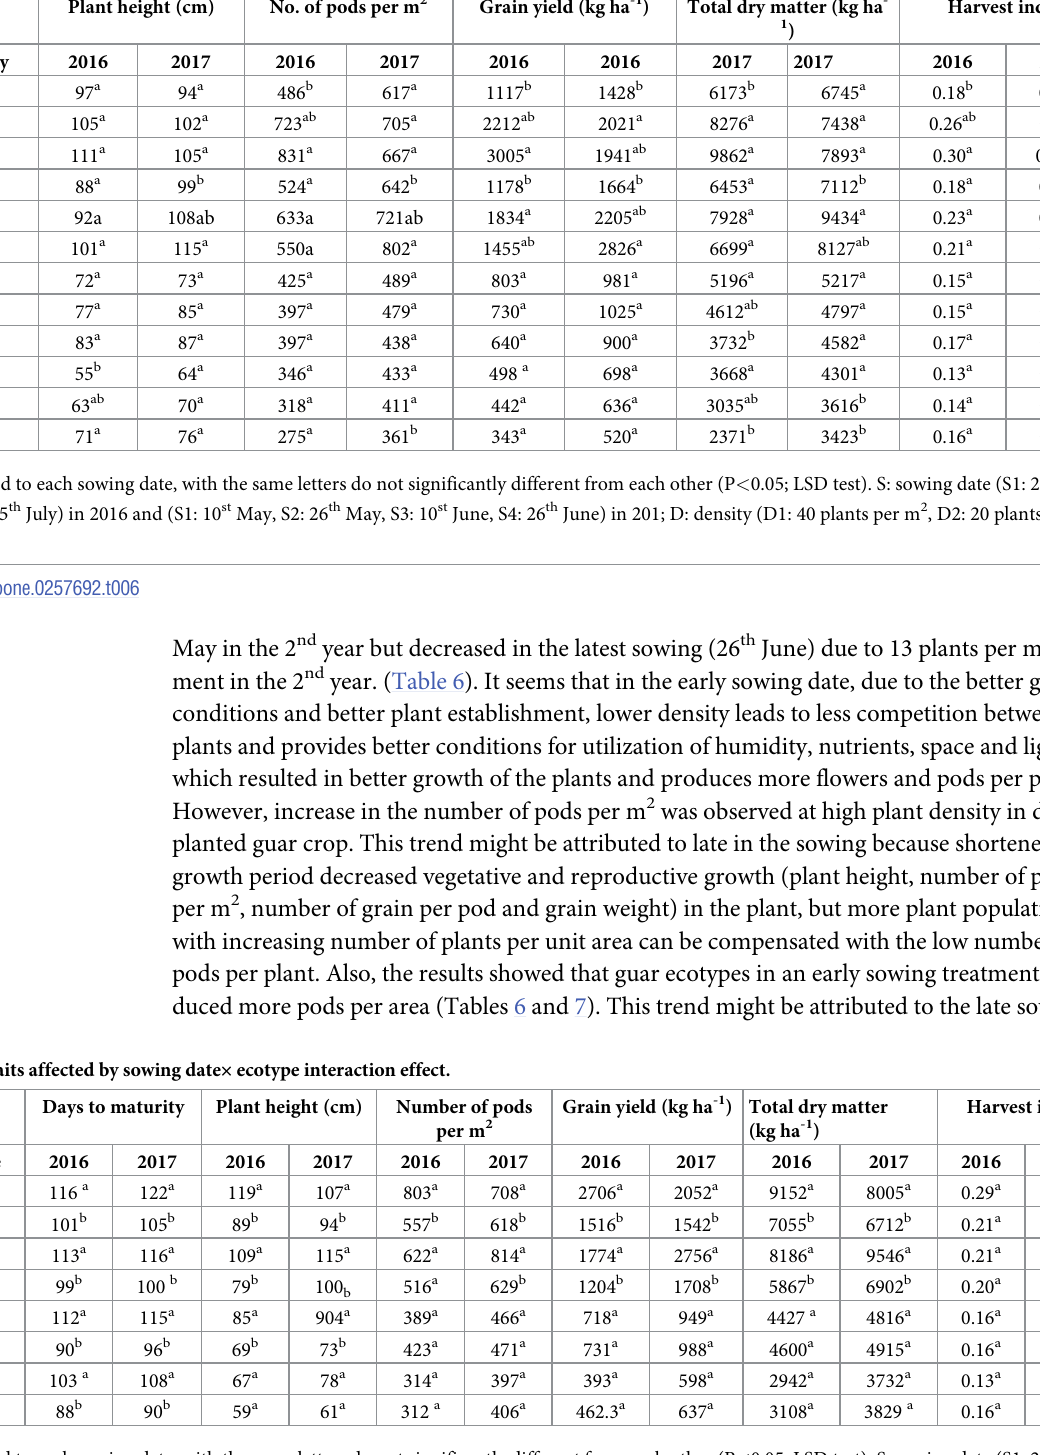
Means within a column related to each sowing date, with the same letters do not significantly different from each other (P < 0.05; LSD test). S: sowing date (S1: 21 st May, S2: 4 th June, S3: 21 st June, S4: 5 th July) in 2016 and (S1: 10 st May, S2: 26 th May, S3: 10 st June, S4: 26 th June) in 2017; E: ecotype (E1: Pakistani, E2: Indian).